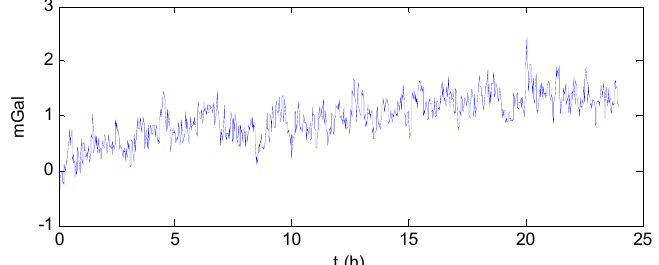
Figure 5. The observed data on 27 May (after filtering with the starting value subtracted).